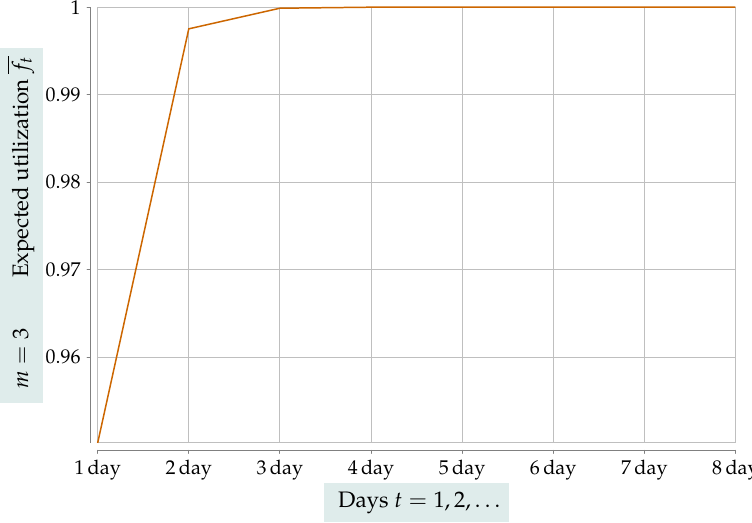
Figure 5. This figure depicts the expected utilization f t , as given by Equation (23), for the 3-DKPRG studied herein.